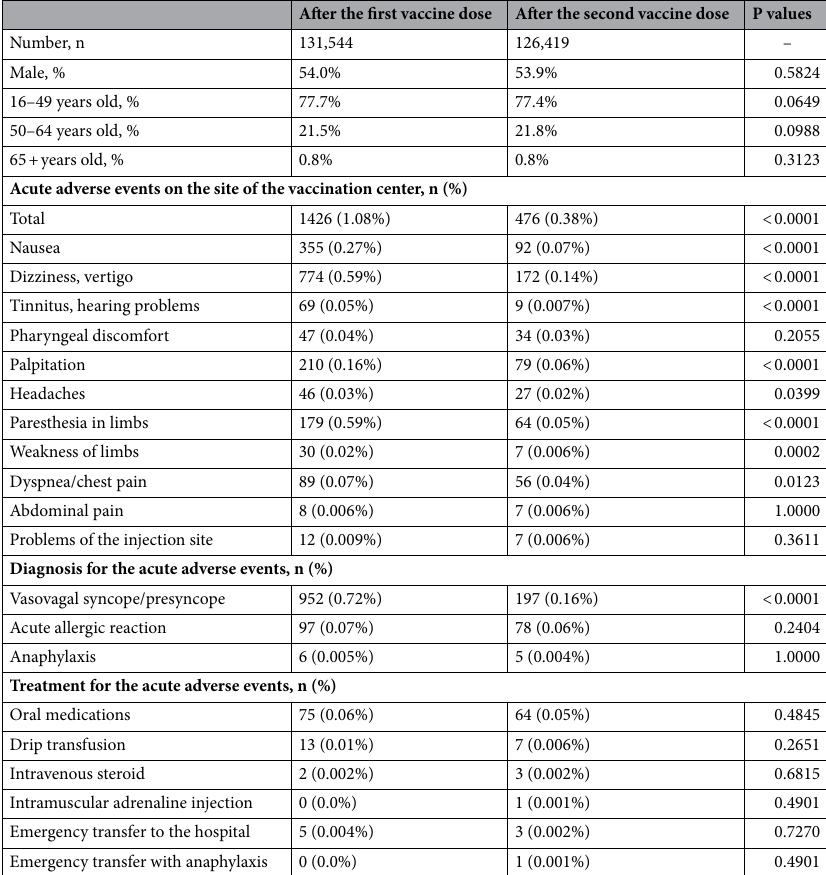
Table 1. Demographics and observed acute adverse events at the vaccination site. The demographic data of the whole recipients of the mRNA COVID-19 vaccines and clinical manifestation and treatments in those with acute adverse events seen on the site of the vaccination center are compared between the first and second vaccine doses. The percentage for each symptom or diagnosis is for the number of overall individuals who received the first or second